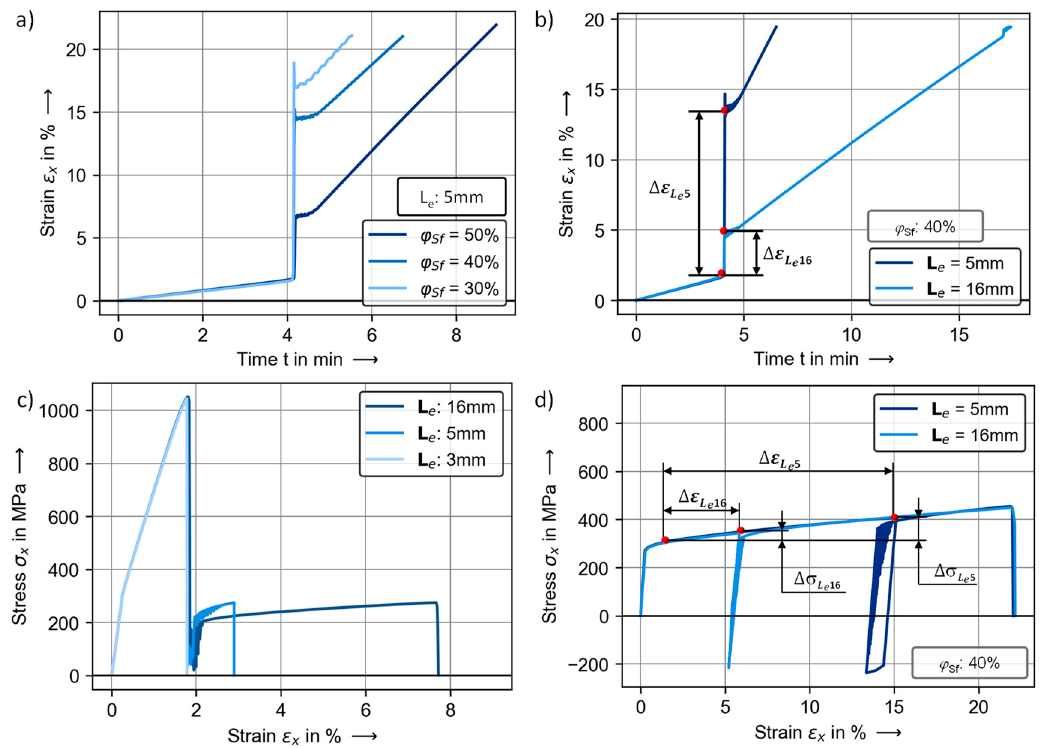
Figure 7. Sudden strain increase at the initial failure for different steel fiber volume fractions in ( a ) and for different element edge lengths in ( b ) and stress–strain behavior of a laminate configuration with a steel fiber volume fraction of 40% for a variation of the element edge length in ( c ) as well as stress–strain behavior of an SFRP layer in the initially damaged elements for different element edge lengths in ( d ).